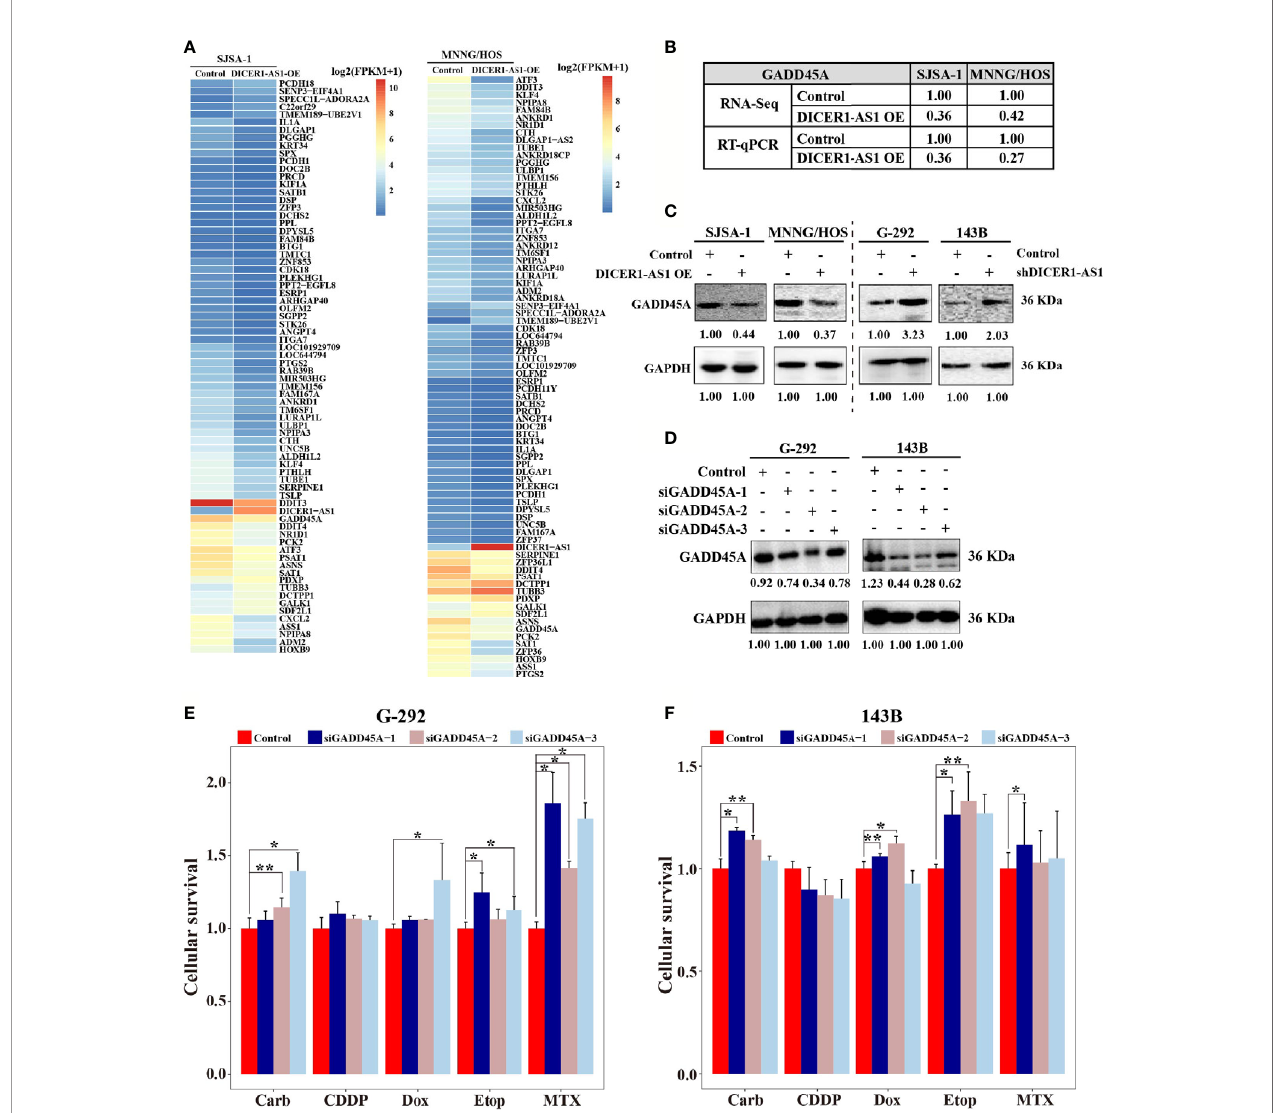
FIGURE 4 | DICER1-AS1 interacts with growth arrest and DNA damage inducible alpha (GADD45A) in OS cells. (A) Hierarchical clustering analysis of mRNAs that were differentially expressed between DICER1-AS1-overexpression with control vector in SJSA-1 and MNNG/HOS cells respectively. (B) The relative GADD45A levels (fold) of DICER1-AS1-overexpression compared with control vectors measured by both RNA-seq and qRT-PCR analyses in MNNG/HOS and SJSA-1 cells, respectively. (C) The GADD45A protein levels with DICER1-AS1-overexpression compared with control vector (pEZ-lv201.1) in SJSA-1 and MNNG/HOS cells, respectively, and in the shDICER1-AS1-transfected versus the sh-NC-transfected G-292 and 143B cells, respectively. (D) The levels of GADD45A protein levels determined by western in the three different region ’ siRNAs transfected into G-292 and 143B cells versus the NC-transfected cells, respectively. (E, F) The CCK8 assays showing cell death triggered by an IC 50 dose of drug in G-292 and 143B cells transfected with GADD45A three different siRNAs versus the negative control (NC) assayed 72 h after treatment with the IC 50 dose of drugs. *p value < 0.05; **p value <